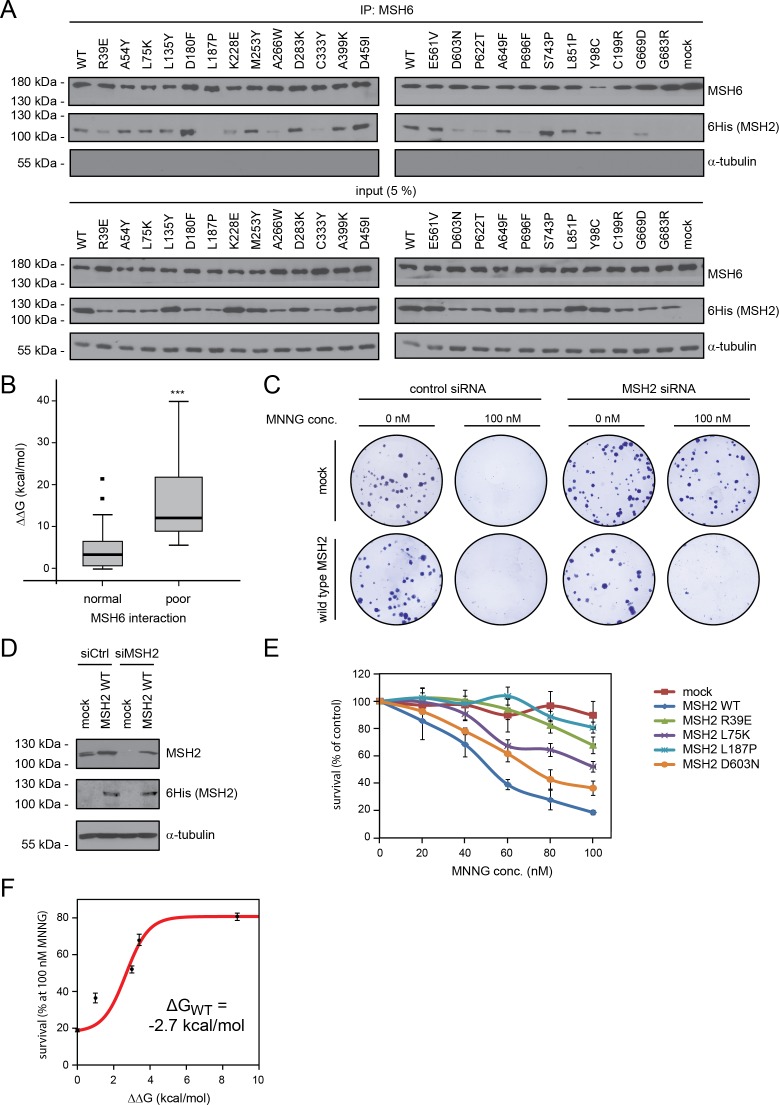
Functional analyses of MSH2 variants.(A) The MSH2 variants were analyzed for interaction with MSH6. Endogenous MSH6 was immunoprecipitated and the precipitated material analyzed by SDS-PAGE and Western blotting using antibodies to the 6His-tag on the MSH2 variants. Input samples (5%) were included as a control. α-tubulin served as a loading control. To obtain sufficient amount of the MSH2 variants the cells were treated with the proteasome inhibitor bortezomib (BZ) for 6 hours before harvest. See also supporting information S4 Fig. (B) The calculated thermodynamic stabilities of the test mutants (vertical axis) are plotted towards categories of normal MSH6 interaction or reduced MSH6 interaction. The horizontal line marks the median and the bars indicate the spread of the data points. *** indicates p < 0.001. (C) U2OS cells stably transfected with either vector (upper row) or wild type 6His-tagged siRNA resistant MSH2 (lower row), were transfected with control siRNA or siRNA to endogenous MSH2 and treated with either 0 or 100 nM MNNG. The surviving colonies were stained with crystal violet. (D) The siRNA-mediated knock-down of endogenous MSH2 is shown by Western blotting using antibodies to MSH2 and the 6His-tag on the recombinant (siRNA-resistant) MSH2. α-tubulin served as a loading control. Note that the recombinant variants are not overexpressed compared to the endogenous MSH2 (E) The survival of the U2OS cells, stably transfected with siRNA to endogenous MSH2, was monitored in response to increasing amounts of the alkylating agent MNNG. Note that cells containing wild type MSH2 fail to survive, whereas the vector control cells survive. The tested MSH2 variants display an intermediate MNNG sensitivity. The error bars indicate the S.E.M. (F) Estimate of the stability of MSH2 assuming that the wild type and MSH2-L187P protein can be used as approximations for fully folded and non-folded protein, respectively. The red line shows the fit to the thermodynamic model.